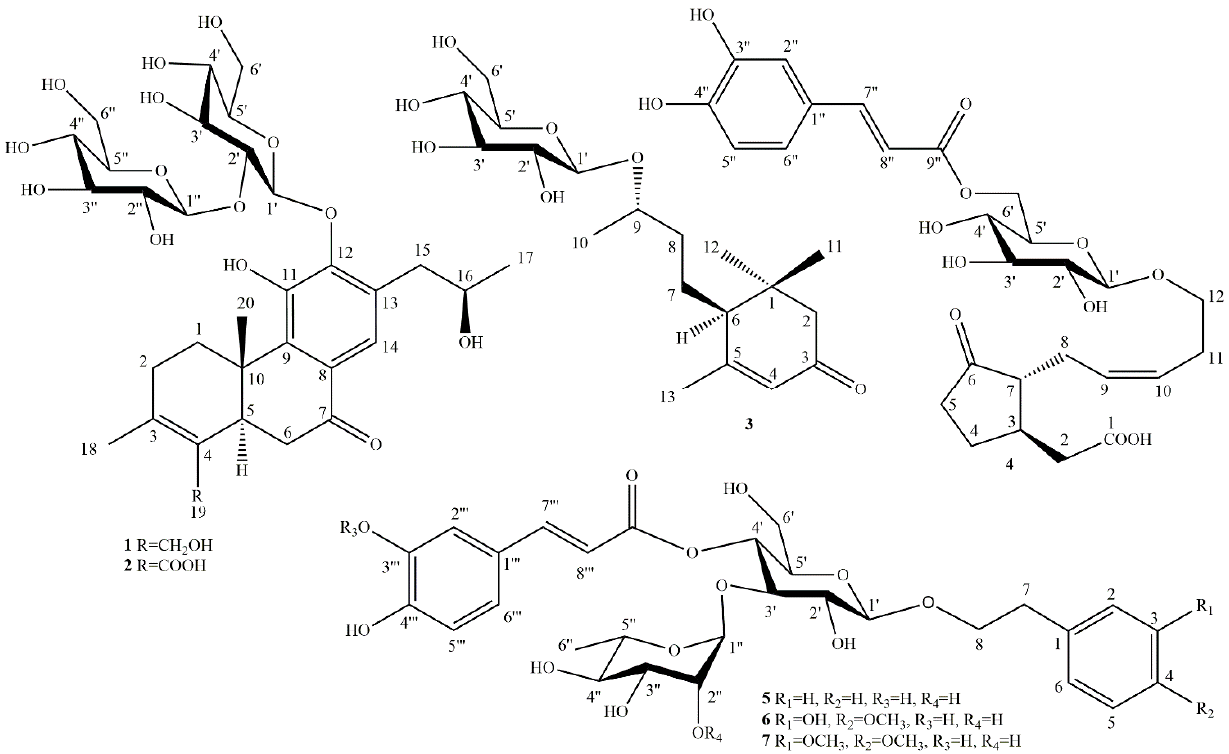
Figure 1. Structures of compounds 1 – 8 isolated from leaves of Clerodendrum infortunatum